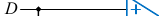
Figure 4. PWM scheme in the proposed operation mode.